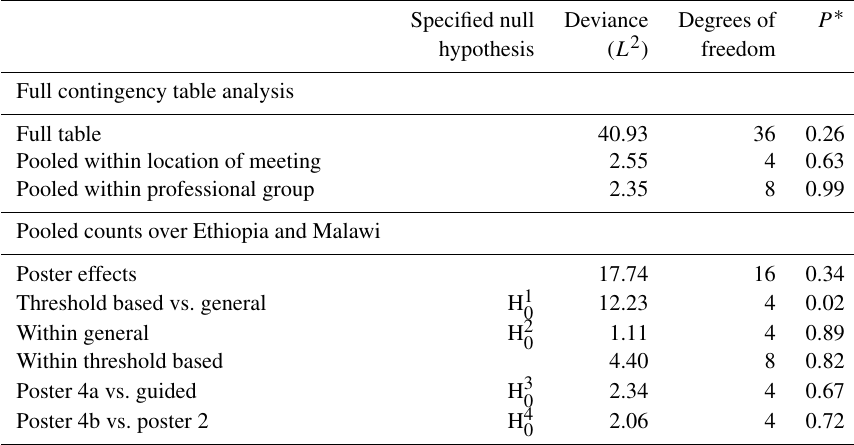
Table 8. Analysis of Q5 according to the location of meeting, professional group and methods that the latter tested on pooled counts over Ethiopia and Malawi.